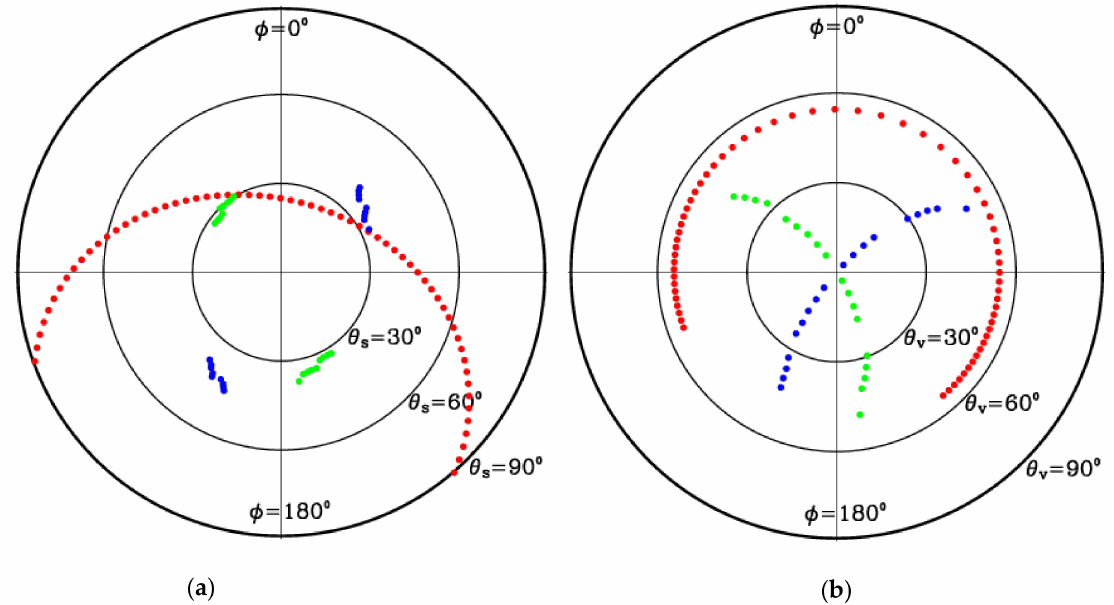
Figure 3. Illumination ( a ) and observation ( b ) geometries corresponding to a geographical location of (47 ◦ 47 (cid:48) N, 10 ◦ 37 (cid:48) E) and an observation period between the days of year 150 and 170. The relative azimuth angle is identical for the two graphs. The convention was chosen such that the top of the graphs (=0 ◦ ) corresponds to the back-scattering regime. The colours of the dots denote observations taken by different sensors as follows: Red: MSG/SEVIRI, Green: Metop/AVHRR, Blue: